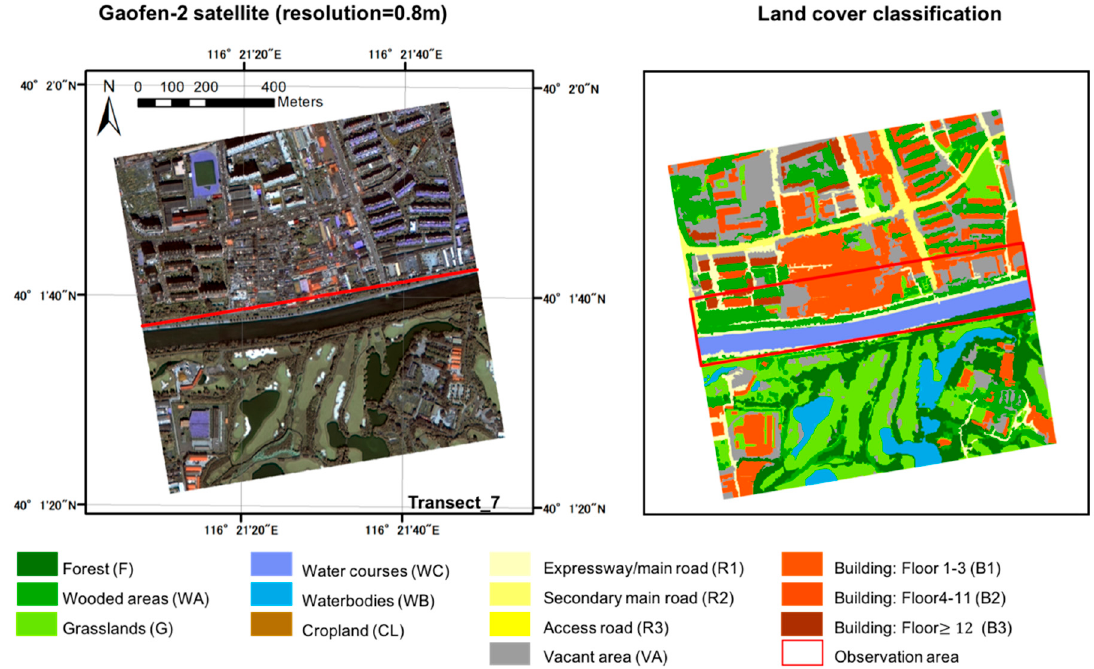
Figure 4. An example of land cover interpretation. Objective-based image analysis can classify forest, wooded areas, grassland, water, cropland, road, building, and vacant area. The reclassification of building and road were based on field surveys and Baidu Street View Map (https://map.baidu.com/). Green spaces were further extracted from the land cover classification to calculate the delta of